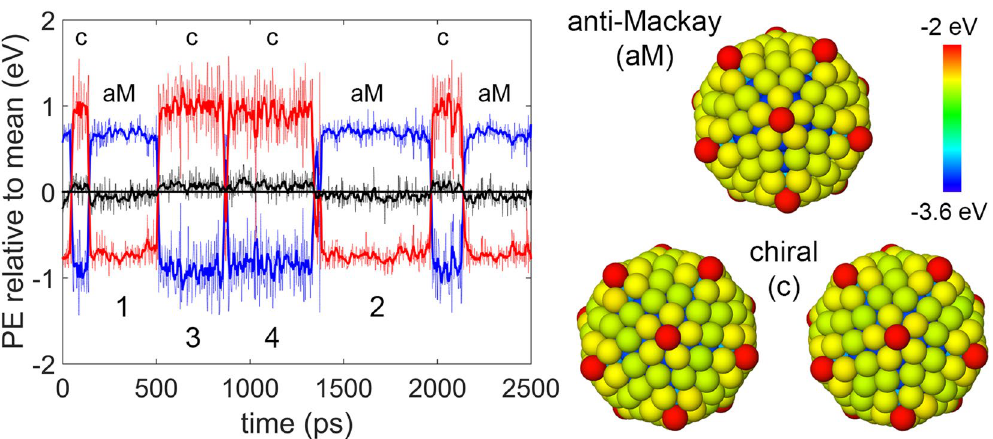
Figure 5. Plot of potential energy (PE) of Ag shell (blue), Cu core (red) and whole structure (black) during heating of Ag Cu at 50 K for 2500 ps. The energy is measured relative to mean of the respective component. 132 147 The solid lines indicate the energy values after smoothing of the actual energy data (dotted lines). Anti-Mackay, chiral icosahedron structures are indicated by aM , c respectively. Also included in this figure are the structures of the nanoalloy with anti-Mackay (aM) stacking and the chiral ( c ) stacking observed during the heating. The chiral stacking can have either clockwise or anti-clockwise rotation of the {111}-like